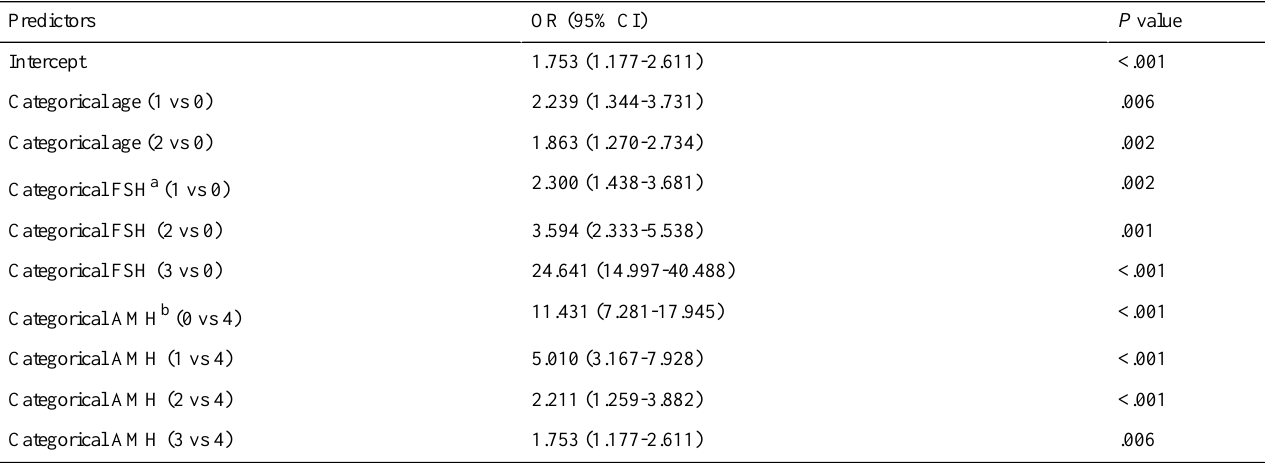
Table 3. The odd ratios of each predictor in the AFA model.